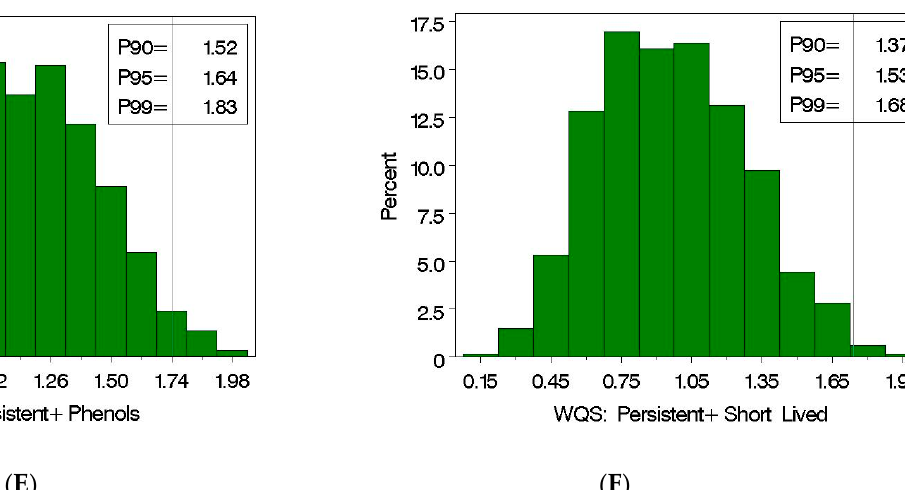
Figure 2: ( A ) Histogram of the stratified interaction WQS index in the SELMA cohort with reference line at selected target value (i.e., one SD below the WQS mean), ( B ) percentage of the WQS index per subject due to persistent chemicals (i.e., PFAS and persistent chlorinated), phenols, plasticizers, and other short-lived chemicals; ( C ) the distribution of the WQS index due to the persistent and 30% of the non-persistent chemicals, i.e., a 70% cut to non-persistent chemicals; the distribution of the WQS index ( D ) eliminating the plasticizers, ( E ) eliminating the plasticizers and the other short-lived compounds, and ( F ) eliminating the plasticizers and the phenols.